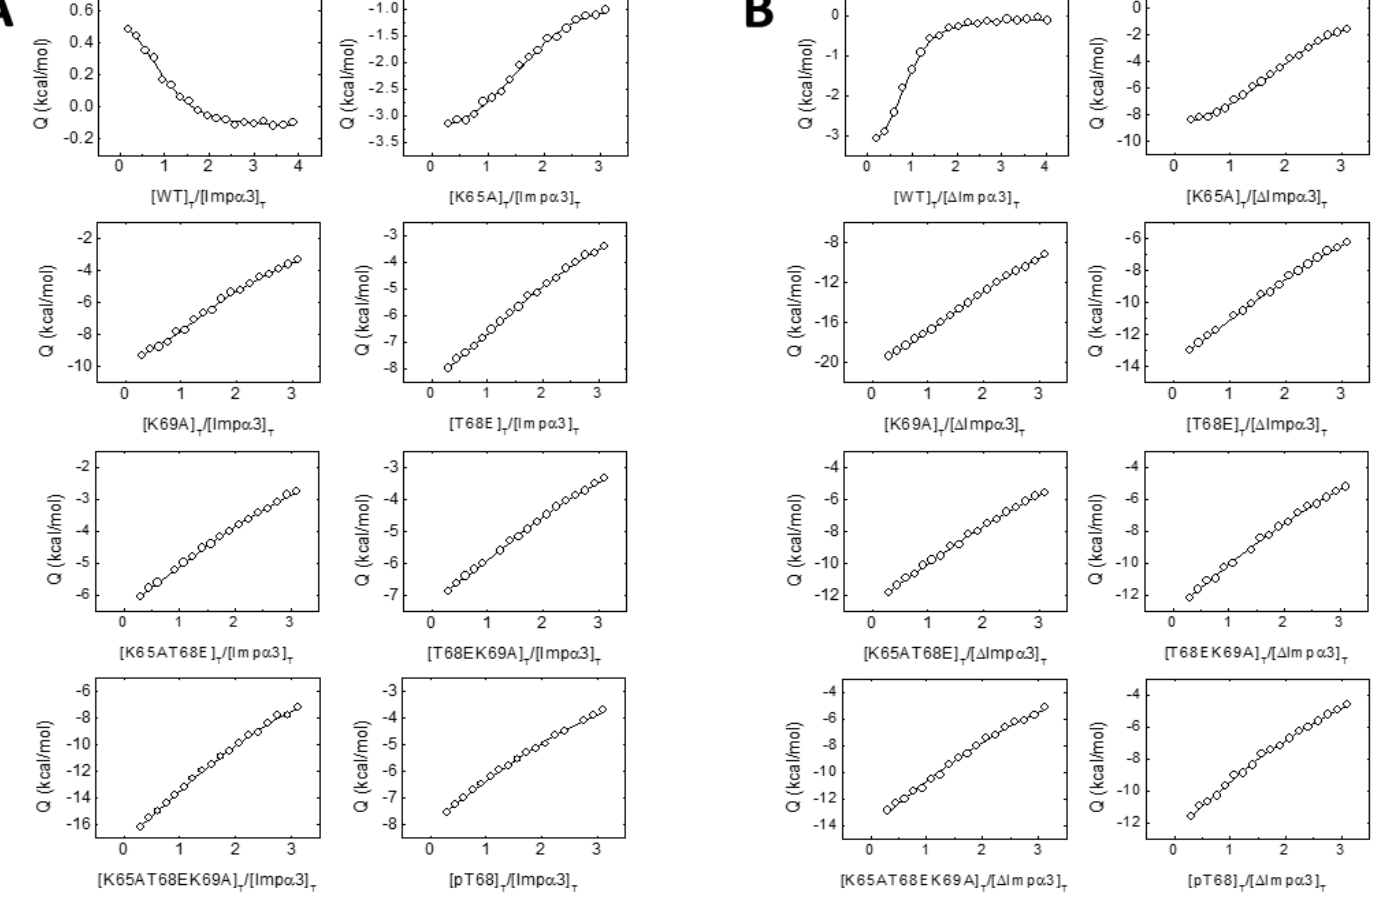
Figure 3. The interaction of the wt and mutant NLS NUPR1 peptides with both importins as measured by isothermal titration calorimetry (ITC). Interaction isotherms (ligand normalized heat effect per injection as a function of the ligand:protein molar ratio) with Imp α 3 ( A ) and Δ Imp α 3 ( B ) are shown. Binding parameters were estimated by a nonlinear least-squares regression data analysis of the interaction isotherms applying a single ligand binding site model, implemented in Origin 7.0.